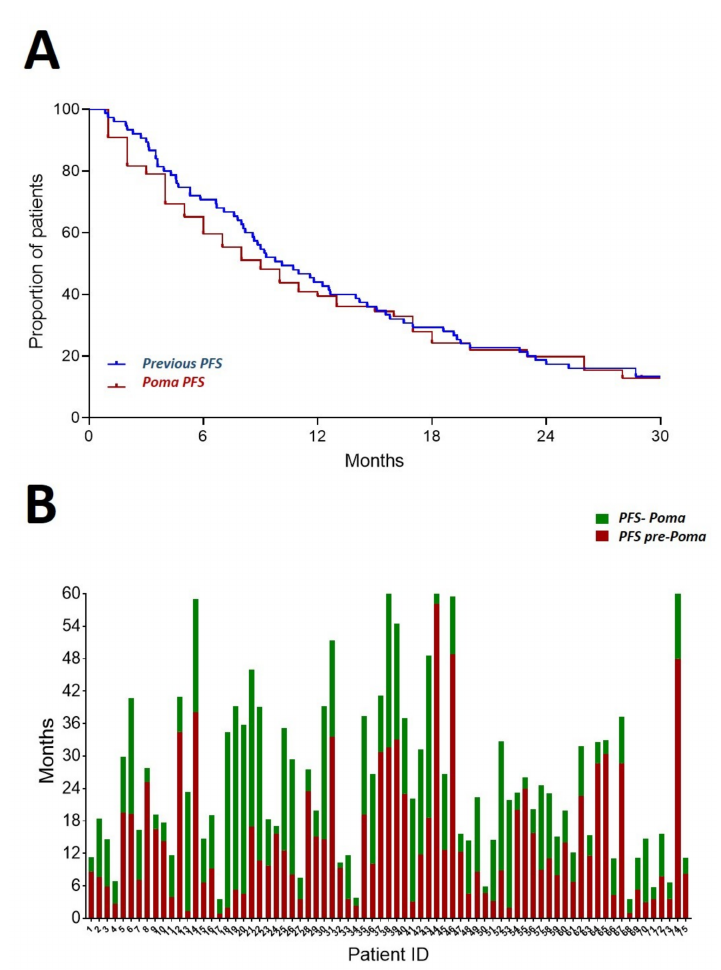
Figure 2. Progression free survival (PFS) before treatment with PomaD and with PomaD. ( A ) Kaplan-Meier curves for direct comparison of PFS before (blue) and after (red) PomaD start are shown; ( B ) PFS before (green) and after (red) PomaD start is shown for each individual patient of the study (data available for 75 / 76 patients).